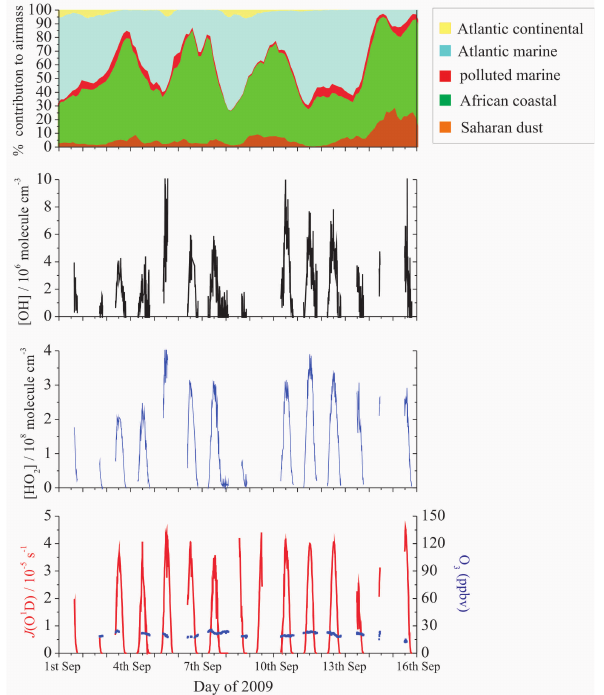
Fig. 5. Time-series of OH, HO 2 and supporting measurements for SOS3. Top panel: source-region percentage contributions to air mass from Atlantic continental (yellow area), Atlantic marine (blue area), polluted marine (red area), African coastal (green area) and Saharan dust (brown area). Middle panels: observed concentrations of OH (five-minute average) and HO 2 (four-minute average). Bot- tom panel: five-minute averaged J (O 1 D) (red line), and the average mixing ratio of O 3 (blue dots); for clarity only the supporting data that are simultaneous with HO x -measurements are